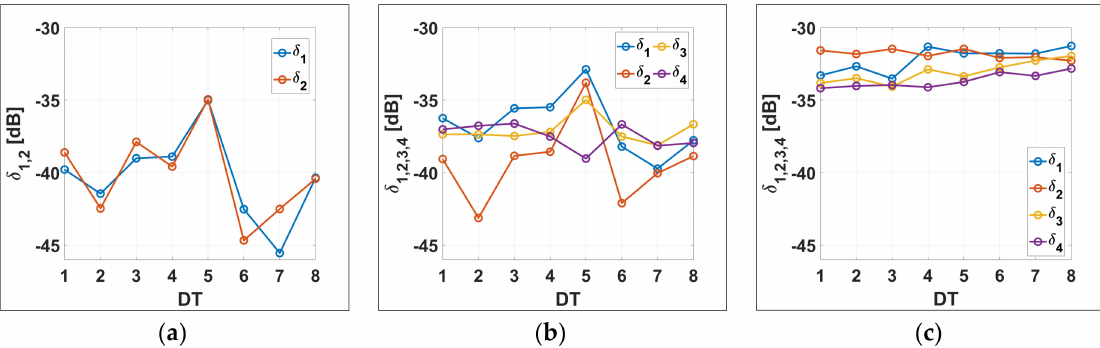
Figure 7. Amplitude estimates of ( a ) δ 1,2 by the Van Zyl method, ( b ) δ 1,2,3,4 by the Quegan method, and ( c ) δ 1,2,3,4 by the Villa method, according to the selected distributed target (DT).